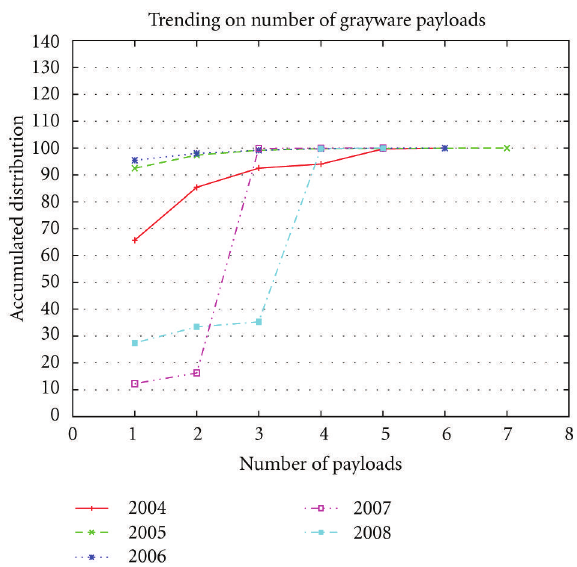
Figure 24: Accumulated distribution of grayware with respect to number of payloads.